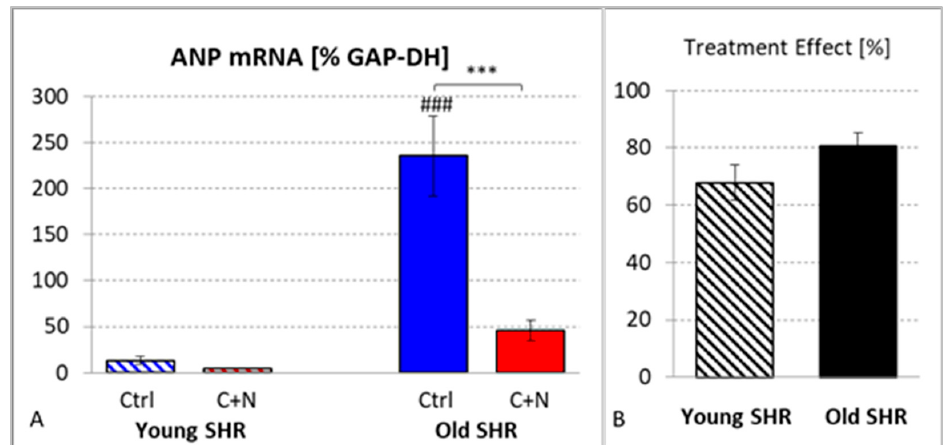
Figure 3. ( A ) mRNA expression of atrial natriuretic peptide in untreated (Ctrl) and treated (C+N) young and old SHRs. ( B ) Treatment effects in young and old SHRs (in % of corresponding average Ctrl value). Significance marks: ⎾ * ⏋ significant difference between marked groups, *** p < 0.001; ### significant difference to corresponding young SHR group, p < 0.001.